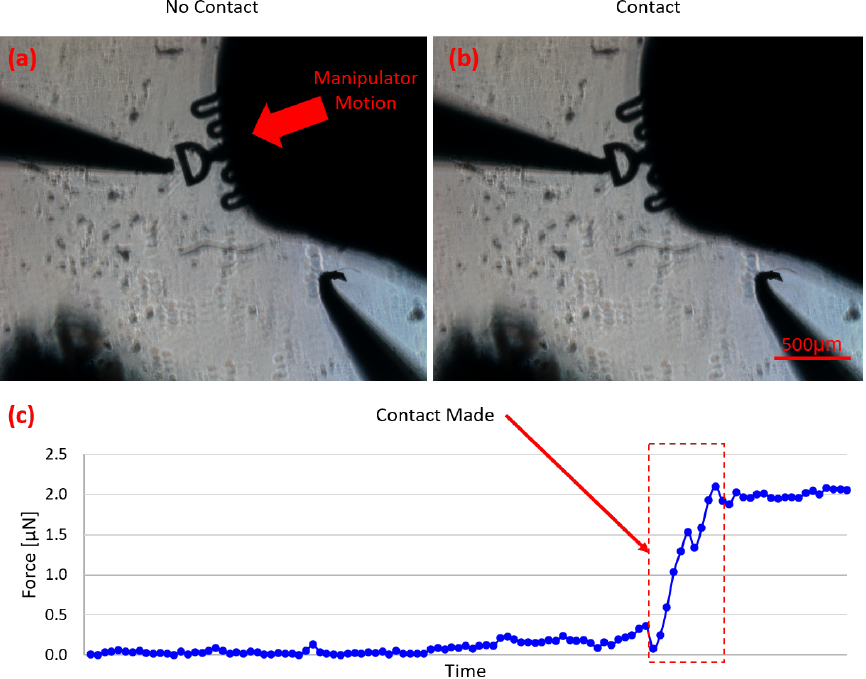
Figure 5. Summary of automated contact detection algorithm. ( a ) The force readings are close to zero, so the manipulator keeps moving forward in small increments. ( b ) Contact has been detected so the manipulator halts its motion and ends the contact detection routine. ( c ) Plot showing the measured forces during this procedure. The point of contact can be clearly identified from examination of the sensed